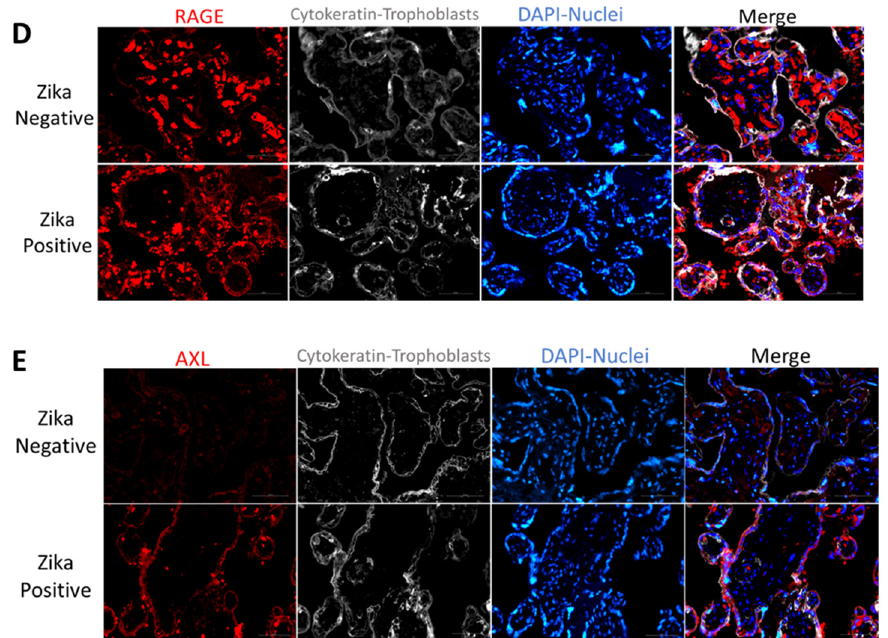
Figure 1. Expression of ZIKV protein and inflammatory proteins in ZIKV-positive and negative placental villi. ( A ) Viral non-structural protein 1 (NS1) labeling of trophoblasts in ZIKV-negative and positive placentas. Representative fluorescence immunohistochemistry of ZIKV-negative placental tissue (upper panel) and ZIKV-infected tissue (lower panel). From left to right, tissue is labeled for anti-NS1 (green), anti-cytokeratin 8 + 18 (white), DAPI for nuclei (blue), and merged figure. Pictures were captured at a magnification of 20 × . ( B ) Macrophage labeling of ZIKV-negative and positive placentas. Representative fluorescence immunohistochemistry of ZIKV-negative (upper panel) and positive placentas (lower panel). The tissue is labeled with anti-Iba1 for placental macrophages or Hofbauer cells (red), with anti-cytokeratin 8 + 18 (white) for trophoblast cells, DAPI for nuclei (blue) and anti-NS1 (green). Pictures were captured at a magnification of 20 × . ( C ) Cystatin B labeling of ZIKV-negative and positive placentas. Protein labeling of ZIKV-positive (upper panel) and negative placentas (lower panel). Placenta tissue was labeled with anti-cystatin B or CSTB (green), anti- cytokeratin 8 + 18 (white) for trophoblast cells, DAPI for nuclei (blue). Pictures were captured at a magnification of 20 × . ( D ) RAGE expression in ZIKV-negative and positive placentas. Representative fluorescence immunohistochemistry of ZIKV-negative (upper panel) and positive placentas (lower panel). Protein is labeled with anti-RAGE (red), anti-cytokeratin 8 + 18 (white) for trophoblast cells, and DAPI for nuclei (blue). Pictures were captured at a magnification of 40 × . ( E ) AXL expression in ZIKV-negative and positive placentas. Representative fluorescence immunohistochemistry of ZIKV-negative (upper panel) and positive placenta (lower panel). Protein labeled with anti-AXL (red), anti-cytokeratin 8 + 18 (white) for trophoblast cells, and DAPI for nuclei (Blue). Pictures were captured at a magnification of 40 ×